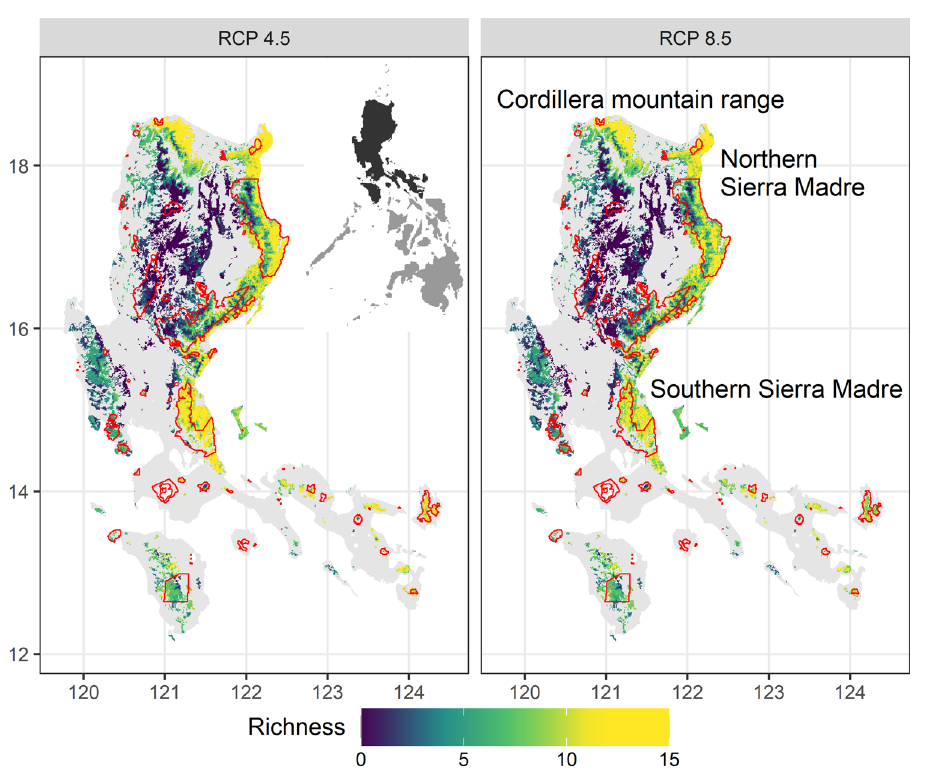
Figure 5. The stacked distribution of stable areas for 19 dipterocarp species in Greater Luzon, Philippines under climate scenarios, RCP 4.5 and RCP 8.5 for 2070; viridis colours indicate dipterocarp richness—lighter colours indicated higher richness and darker colours indicated lower richness—and protected areas were demarcated in red. Areas of especially high species richness but were not currently protected include lowland regions of the northern Sierra Madre, southern Sierra Madre and Cordillera mountain ranges. The maps were created in R using the raster and ggplot2 package 66,67,121